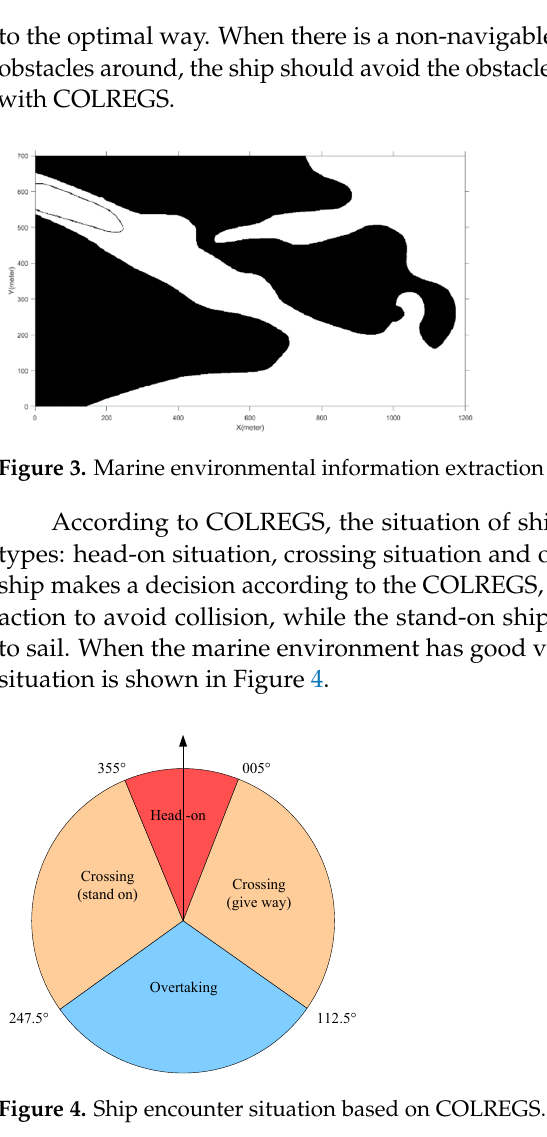
Figure 3. Marine environmental information extraction and processing.